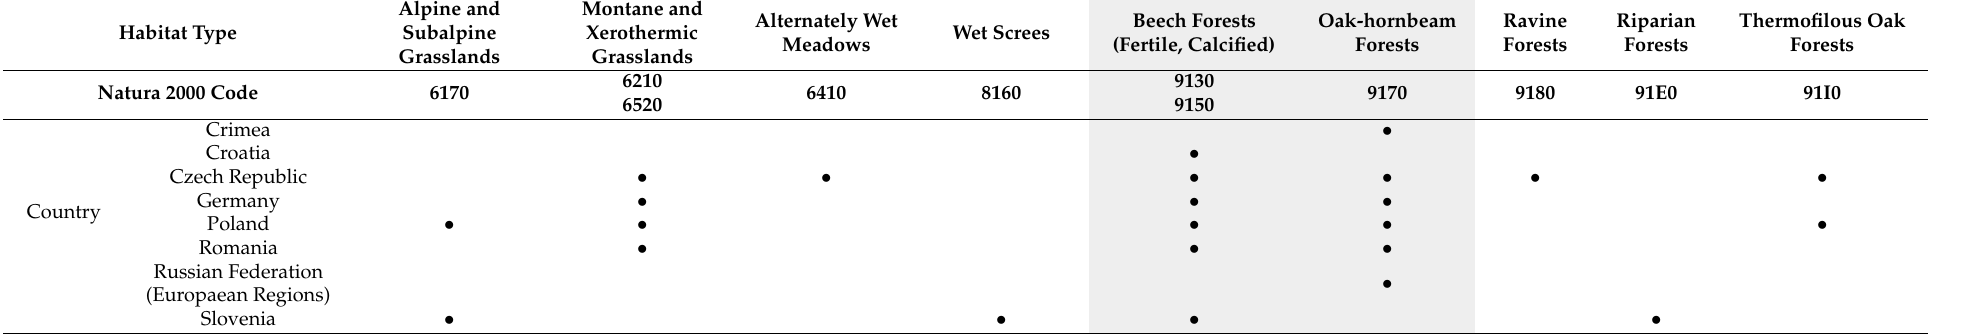
Table 4. List of Natura 2000 habitats with Cypripedium calceolus sites in exemplary European